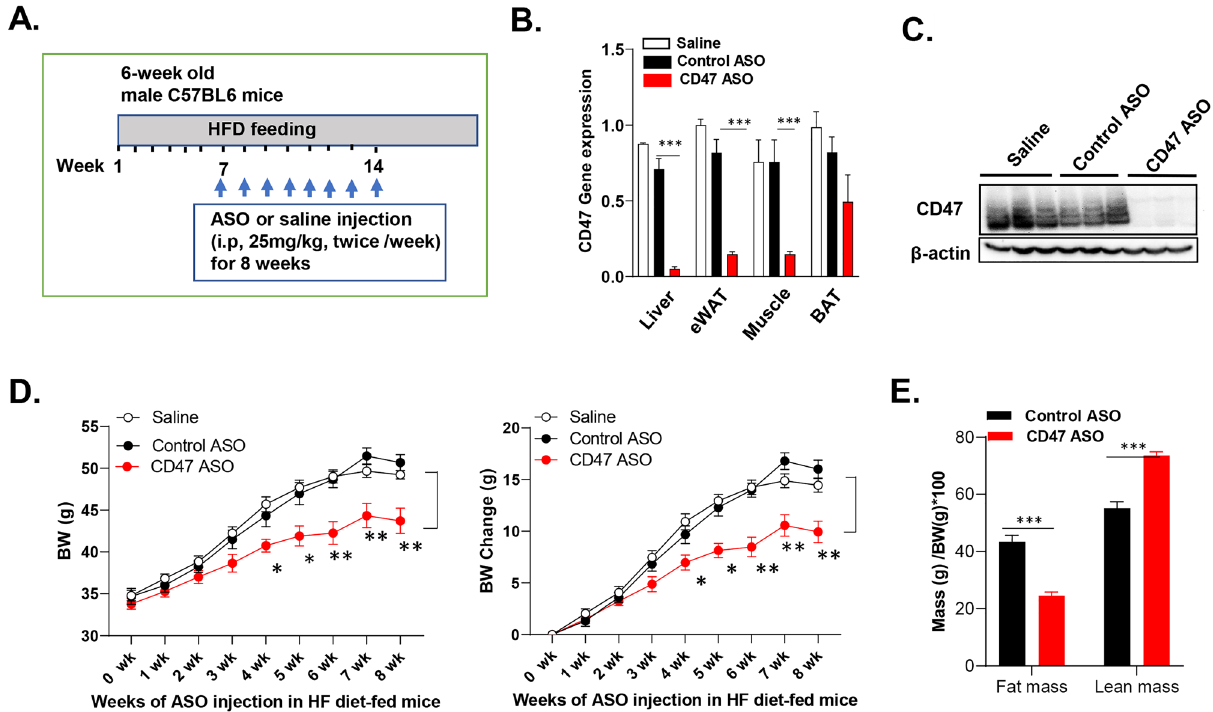
Figure 1. CD47ASO treatment induced weight loss and reduced adiposity in diet-induced obese mice. ( A ) Schematic diagram of experimental setting; ( B ) CD47 mRNA levels from different tissues after saline or ASO treatment by qPCR; ( C ) CD47 protein levels in liver by immunoblotting (cropped blots are displayed); ( D ) Weekly body weight and body weight change after ASO treatment; and ( E ) Body composition (fat mass and lean mass) detected by EchoMRI. HFD: high fat diet. Data are represented as mean ± SE (n = 4–7 mice/group). * P < 0.05, ** P < 0.01, *** P <